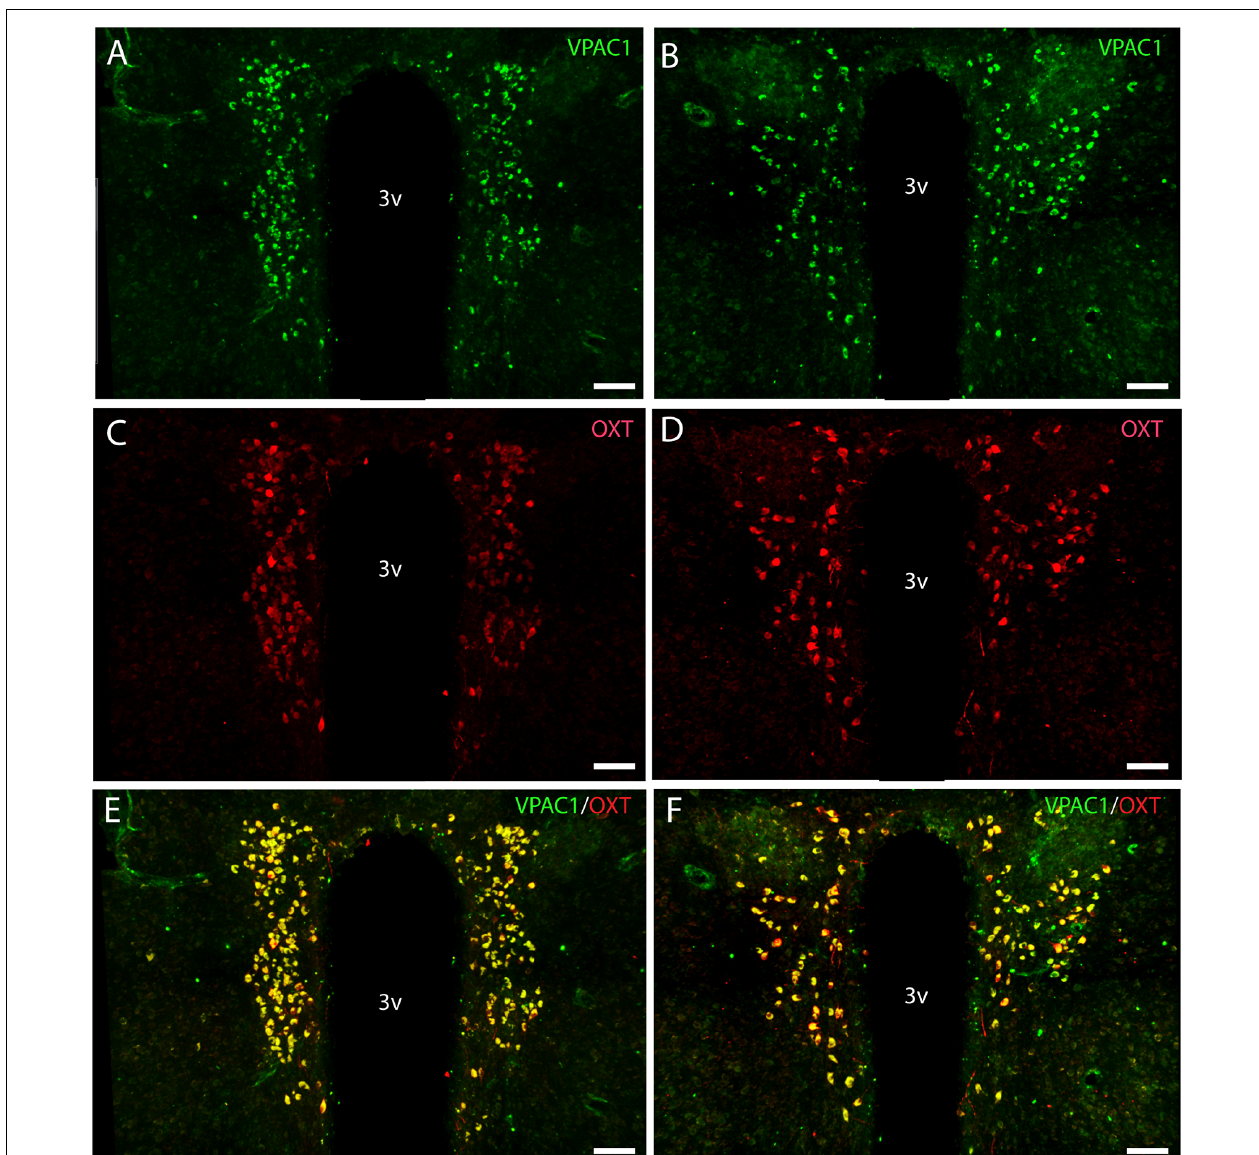
FIGURE 3 | Distribution of VPAC1 (green) and oxytocin (OXT; red) immunoreactivity in the mid and rostral part of SCN and PVN in a wild-type mouse. Images (A–F) represent maximal projections of 16 digital sections in a Z -stack ( Z = 2 µ m). (A,B) show immunoreactivity for VPAC1 in the rostral and mid part of PVN. (C,D) show immunoreactivity for OXT in the rostral and mid part of PVN. Colocalization between VPAC1 and OXT in the rostral and mid part of PVN is visualized in (E,F) using IMARIS colocalization module (see “Materials and Methods” section). Scale bars: (A–F) = 80 µ